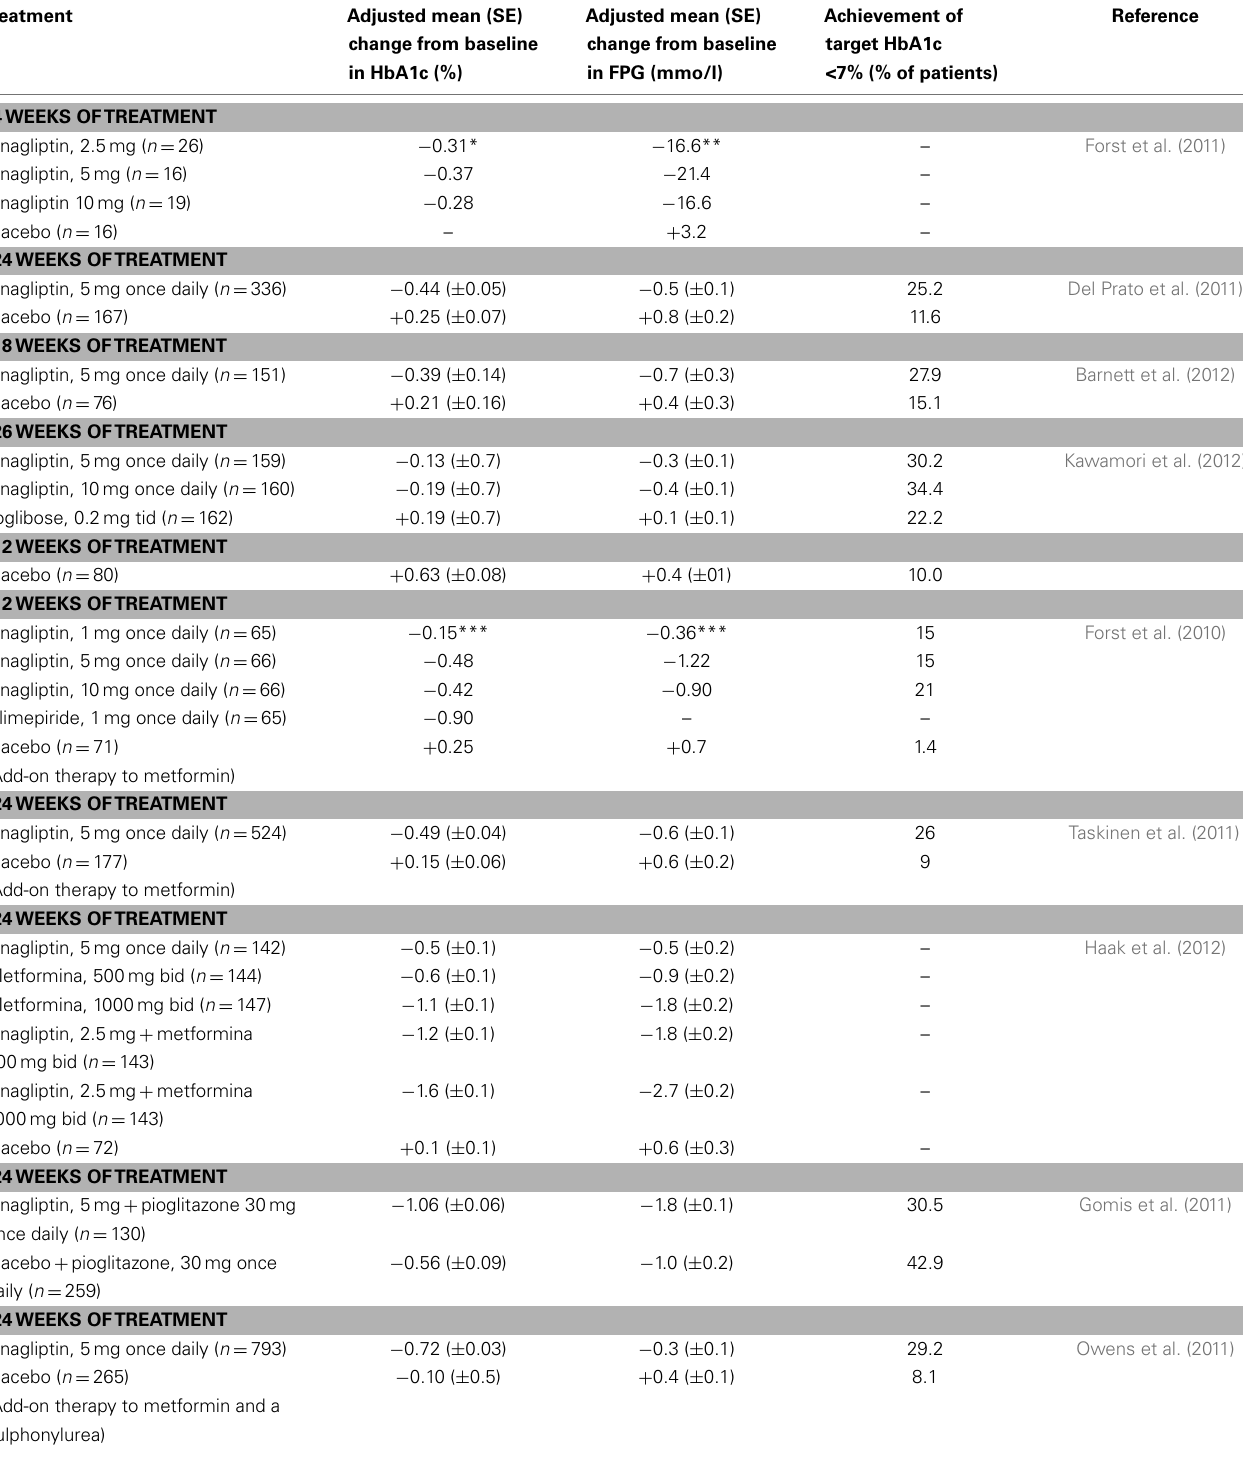
Table 1 | Summary of major results obtained with linagliptin in clinical studies.